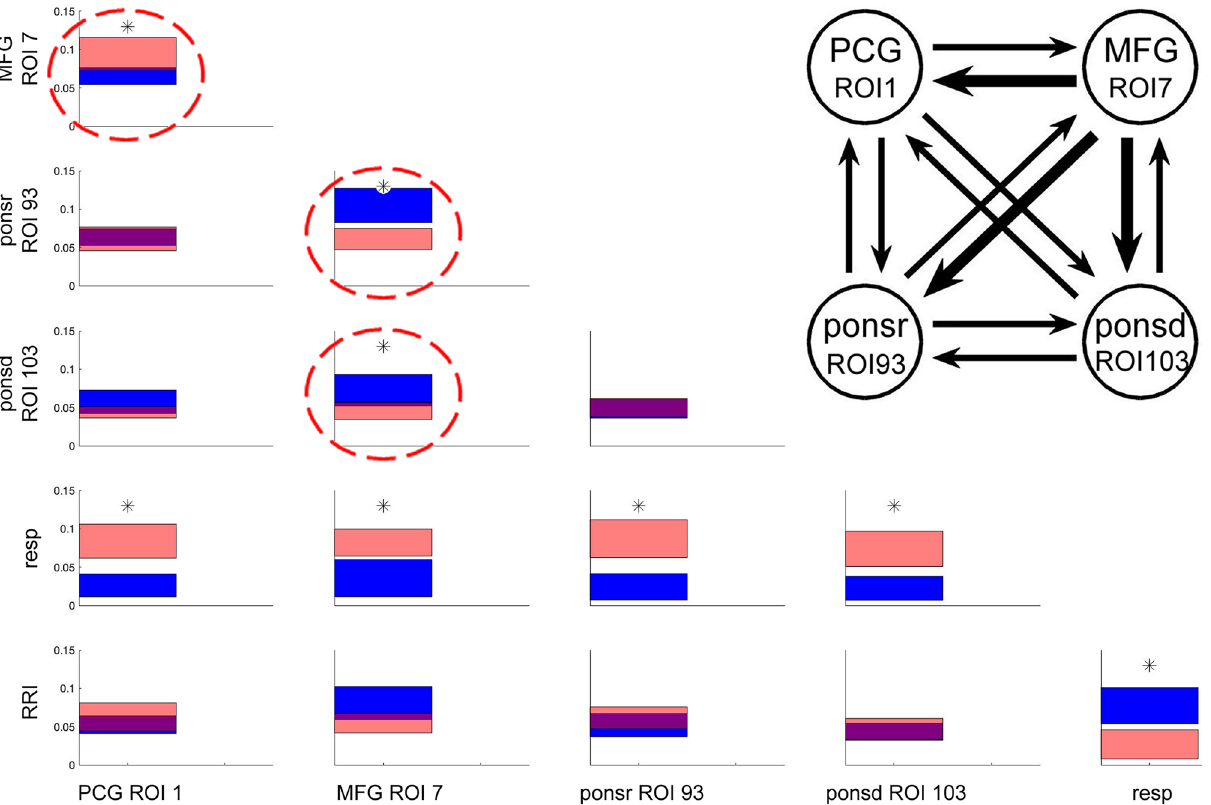
Figure 5. Significant differences between inflows/outflows for HA in 0.05–0.15 Hz band. and insert with coupling strength for BOLD signals only. Note, the strong flow from MFG (ROI 7) to rostral pons (ROI 93) and caudal pons (ROI 103; blue color) and from MFG to the PCG (red color) with significant differences, namely a predominant flow from MFG to PCG, ponsr and ponsd (marked by stippled circles). For further explanations, see Fig. 4.